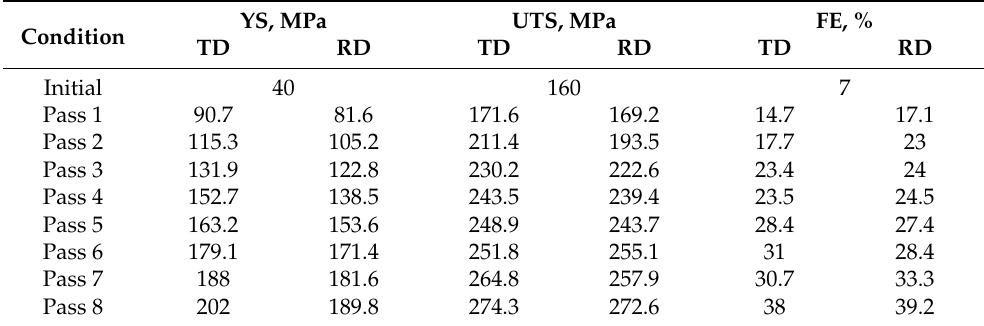
Table 2. Summarized mechanical properties of AZ31 magnesium alloy sheets (YS: yield stress; UTS: ultimate tension stress; FE: fracture